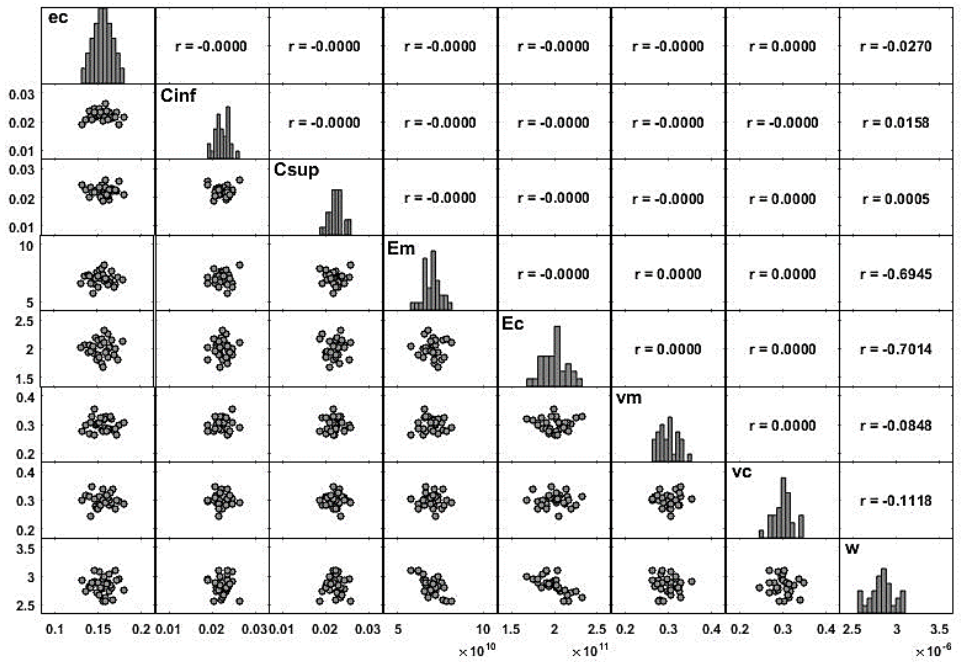
Figure 7. Matrix plot of the modeling parameters (inputs and output): case 3.2.2 — Thicker core.